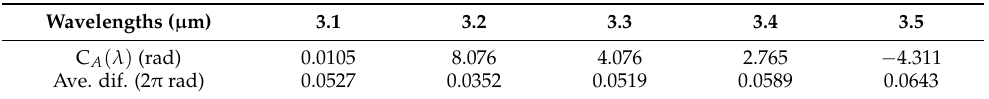
Table 3. Phase corrections and average differences of the aperture metalens at wavelengths from 3.1 to 3.5 µ m.